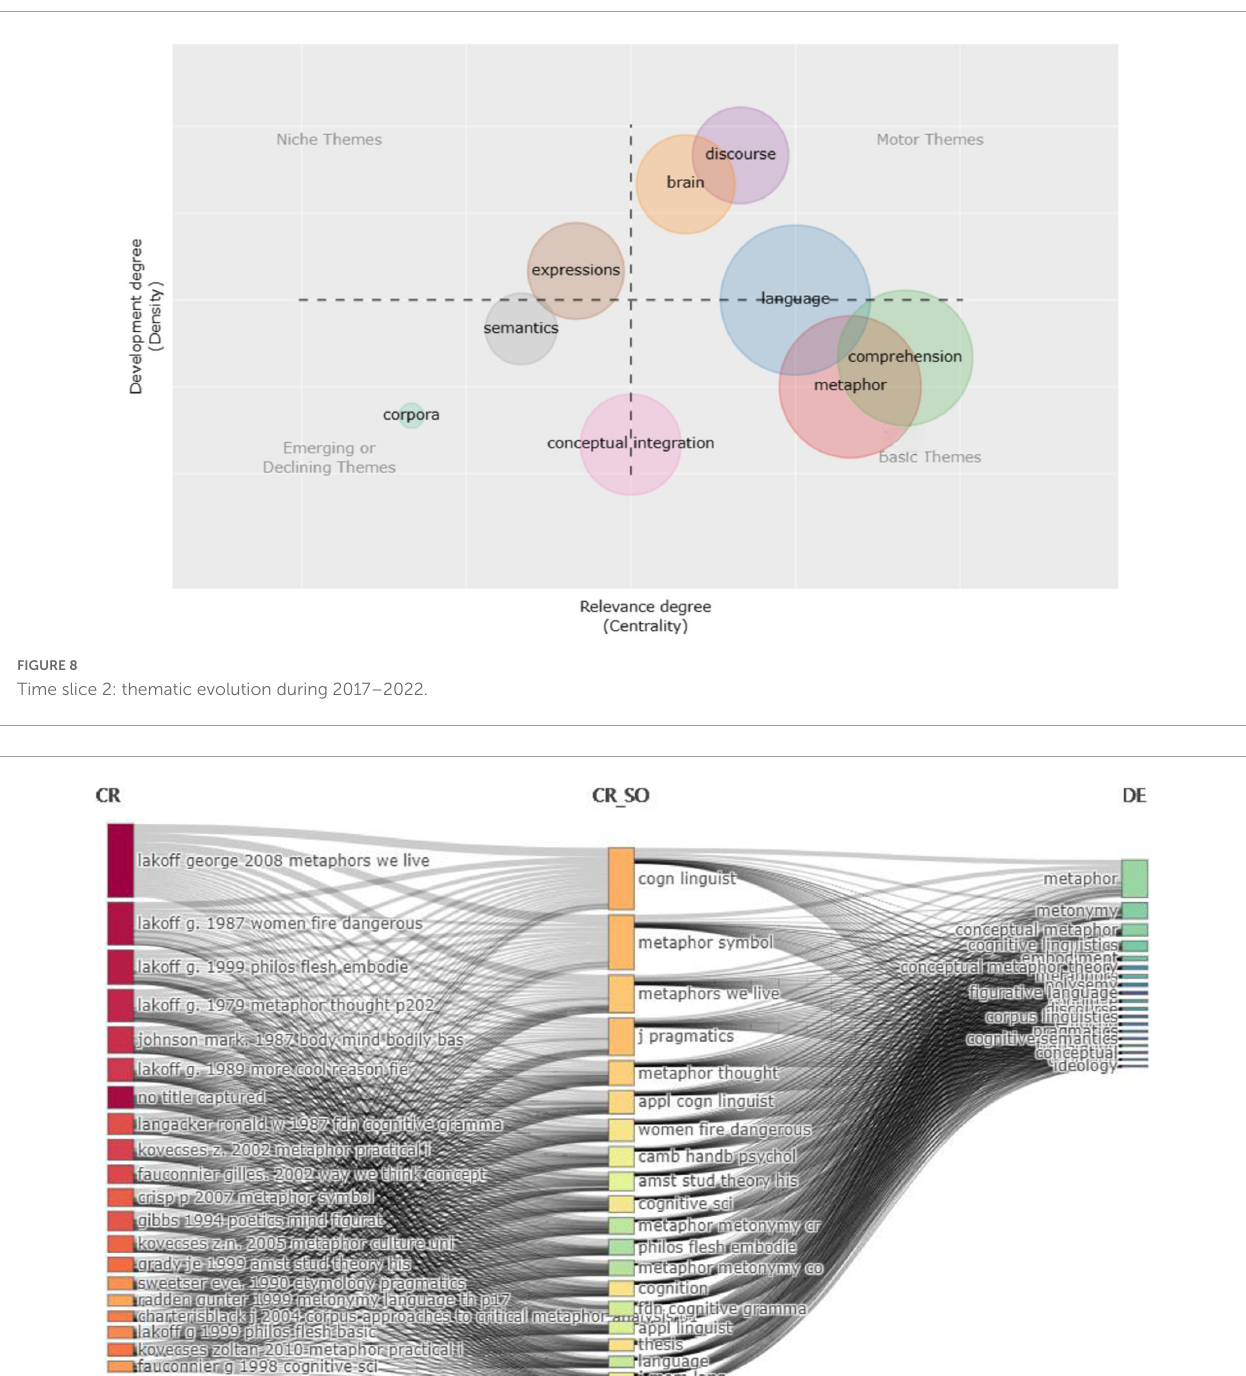
FIGURE9 Three-field plot. The middle field is cited sources, the left refers to references, and the right refers to the author’s